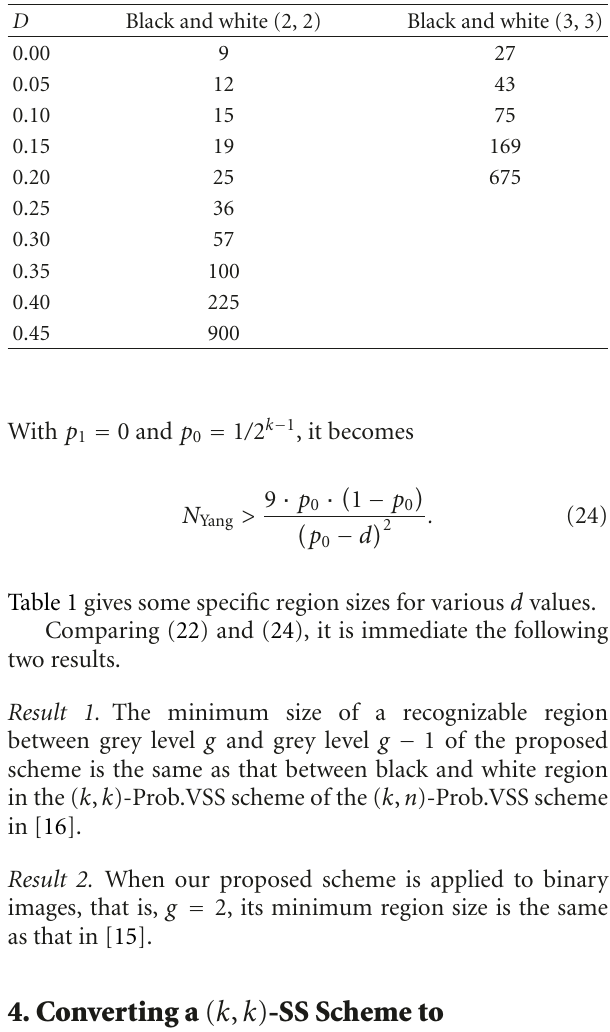
Table 1: Minimum region sizes of a binary image with the proposed greyscale ( k , k )-VSS scheme or the scheme of